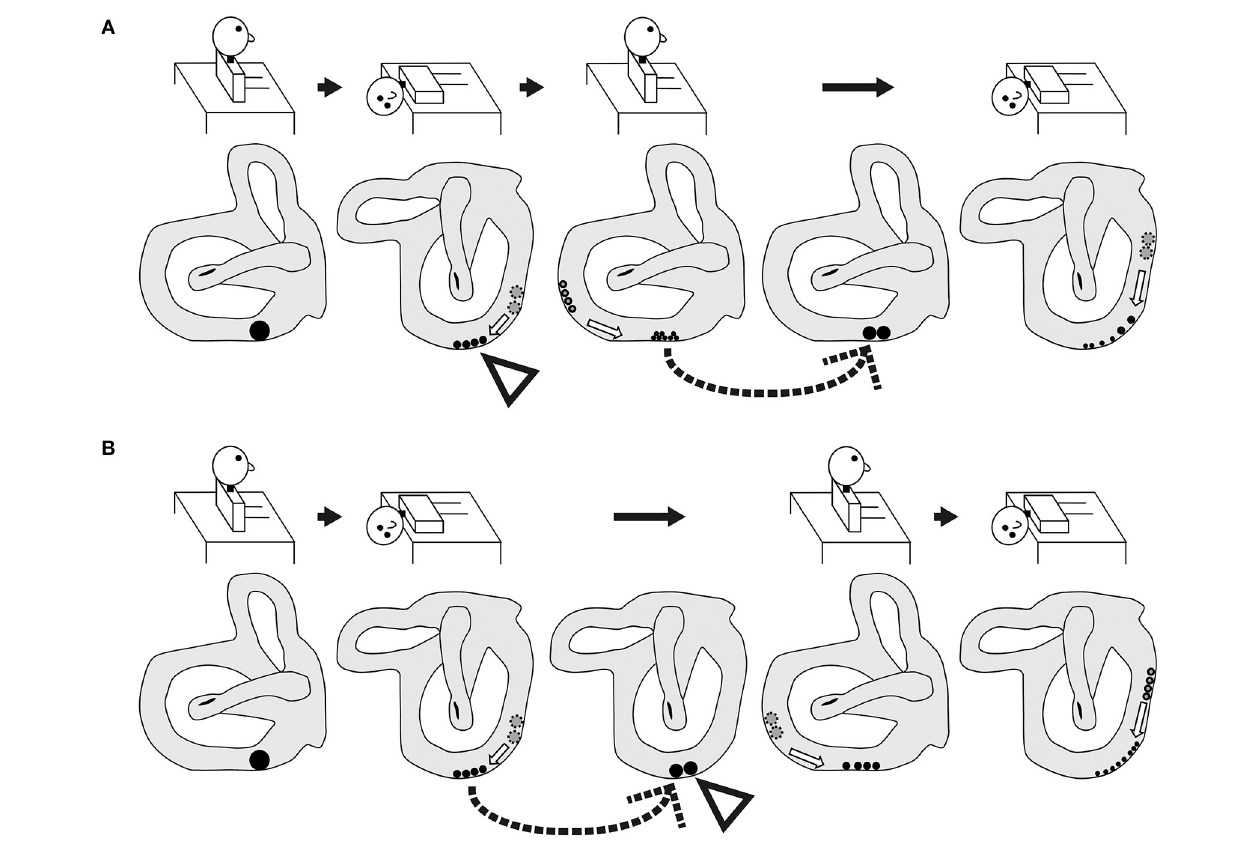
FIGURE 6 | Schematic of the expected shape and movement of otoconial debris based on the popular theory of the pathophysiology of BPPV fatigue. (A) Group A. As shown by the dotted arrow, the dispersed otoconial debris returns to a mass during the sitting head position following a 10-min interval after the reverse Dix–Hallpike test. Therefore, strong positional nystagmus should be induced by the second Dix–Hallpike test as the mass of the otoconial debris (rather than dispersed otoconial debris) moves along the semicircular canal during head movement in the second Dix–Hallpike test. (B) Group B. As shown by the dotted arrow, the dispersed otoconial debris returns to a mass during the supine position with the head turned to the affected side following a 10-min interval after the first Dix–Hallpike test. Therefore, strong positional nystagmus should be induced by the reverse Dix–Hallpike test as the mass of otoconial debris (rather than dispersed otoconial debris) moves along the semicircular canal during the head movement in the reverse Dix–Hallpike